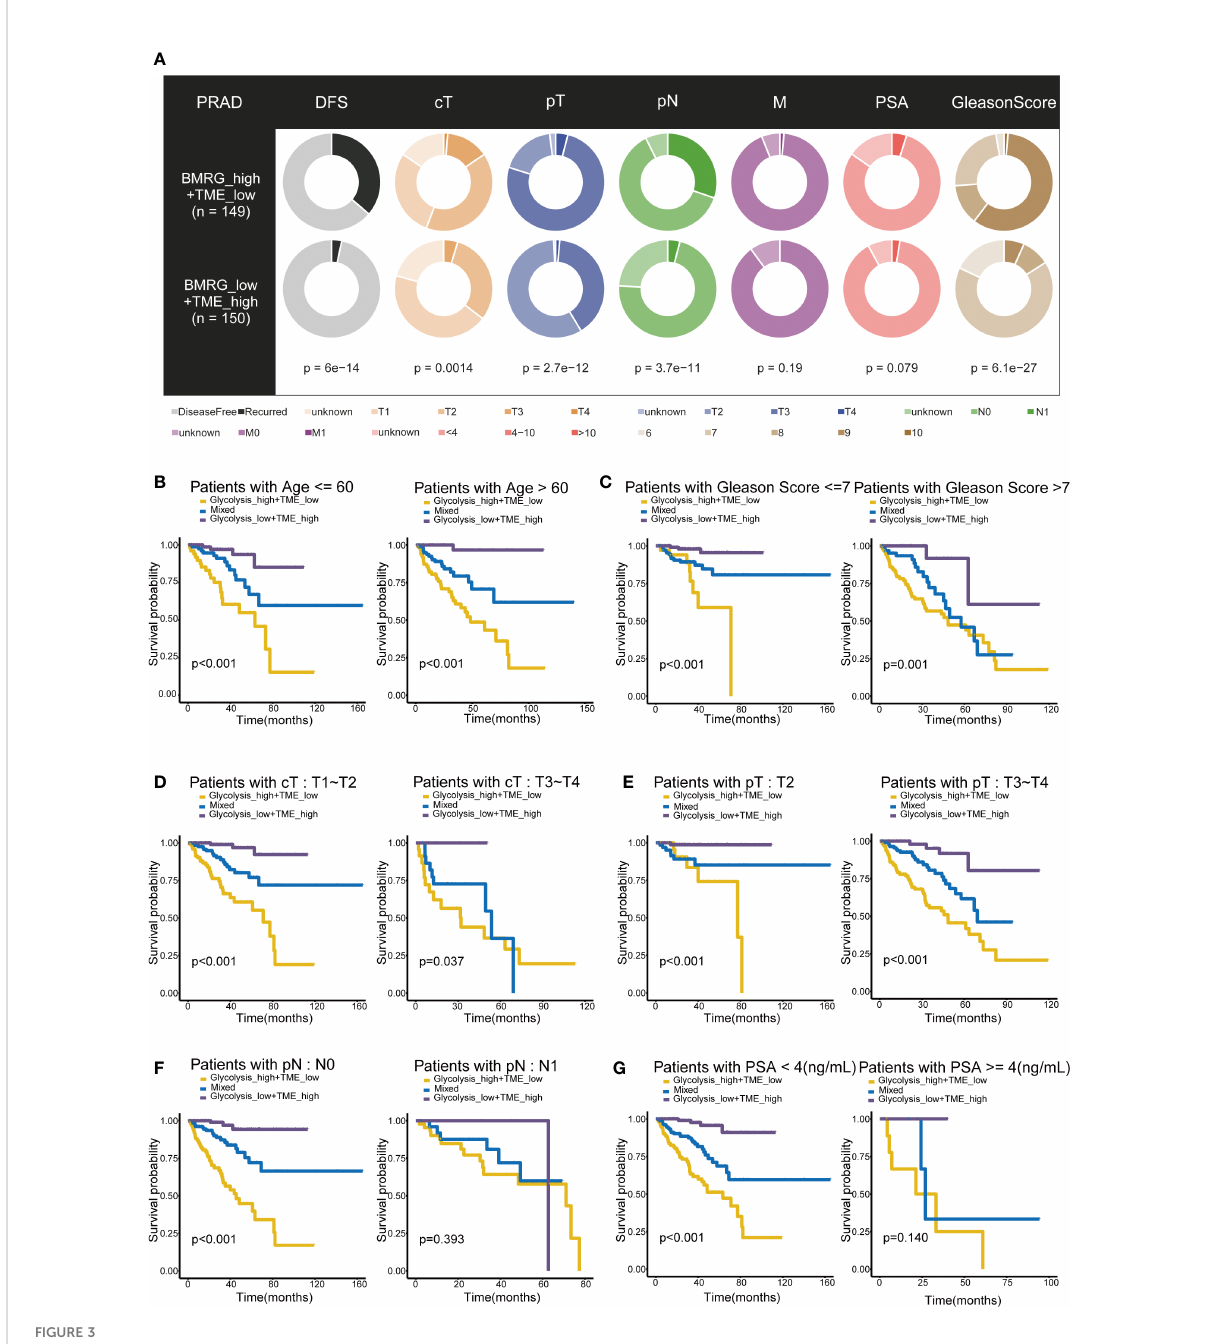
FIGURE 3 Prognostic value of Glycolysis-TME Classi fi er. (A) Different distribution of clinicopathological features of PRAD patients between the Glycolysis high /TME low and Glycolysis low /TME high . (B – G) Kaplan – Meier survival subgroup analysis according to the Glycolysis-TME Classi fi er strati fi ed by age, Gleason Score, clinical T stage (cT), pathological T stage (pT), pathological N stage (pN) and the concentration of prostate- speci fi c antigen